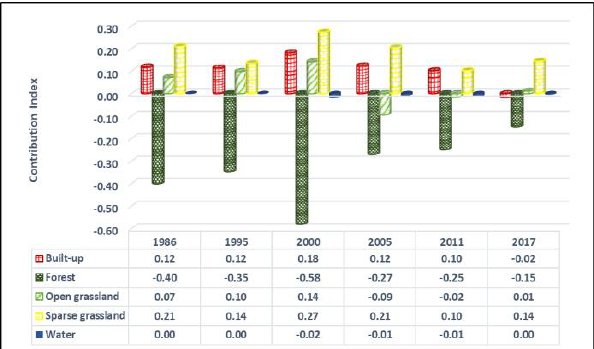
Figure 8: Contribution index of land